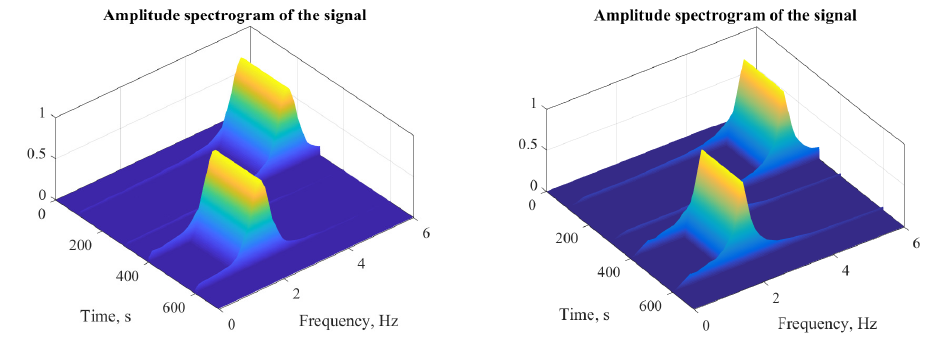
Figure 12. ( a ) STFT spectrogram ( b ) Spectral observer